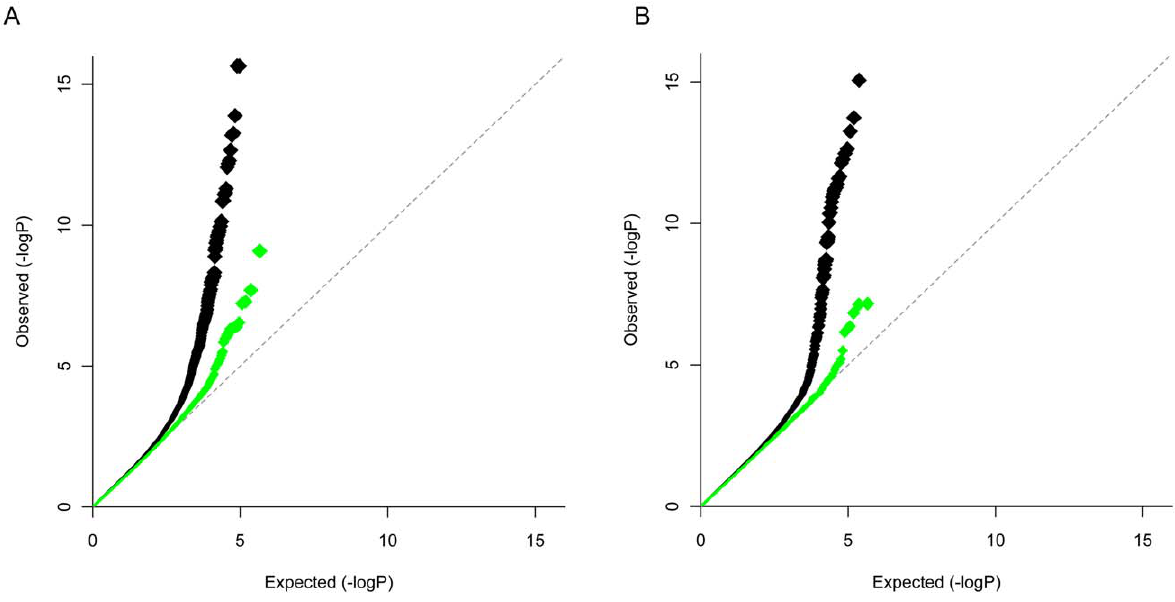
Figure 3. QQ plot of CD-RA meta-analysis by directional method and opposite allelic effect. CD-RA inverse variance weighted meta- analysis assuming allelic effects in the same direction in the two diseases (panel A) and opposite allelic effects (panel B). Black – all loci except the MHC region (chr. 6: 20–40 Mb). Green – all loci except MHC and established CD and RA regions (1 MB around previously validated SNPs excluded).